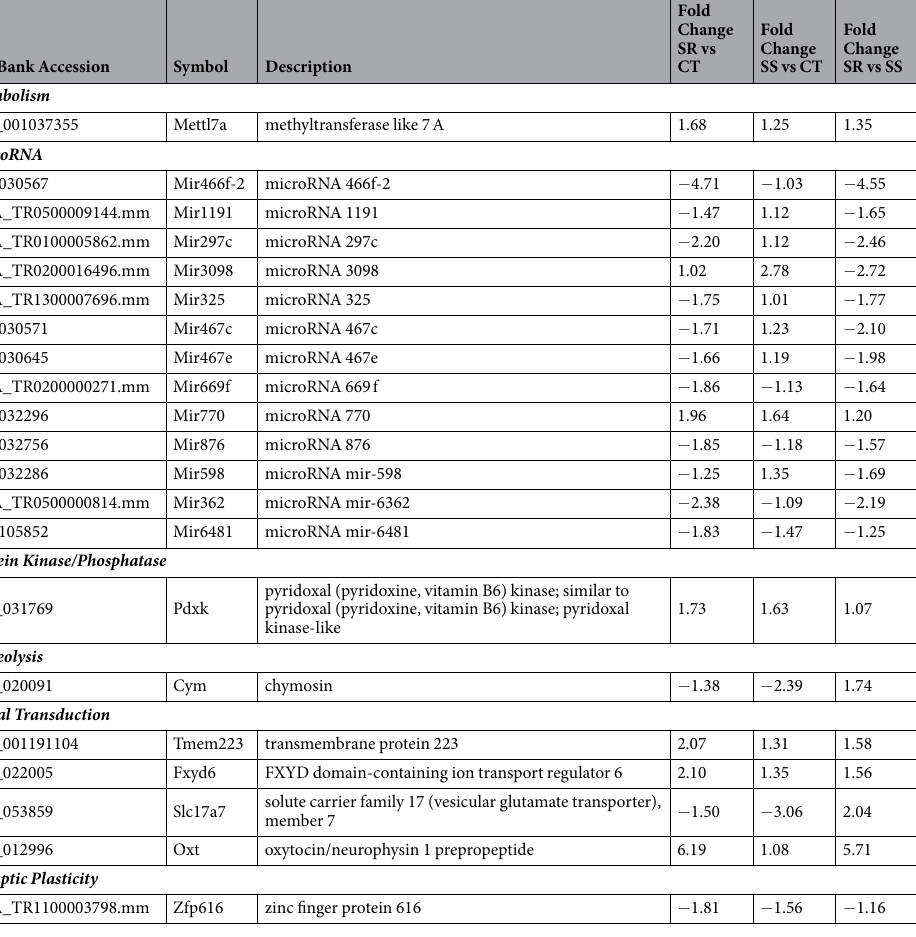
Table 1. Classification of NAc genes with altered expression after METH SA and